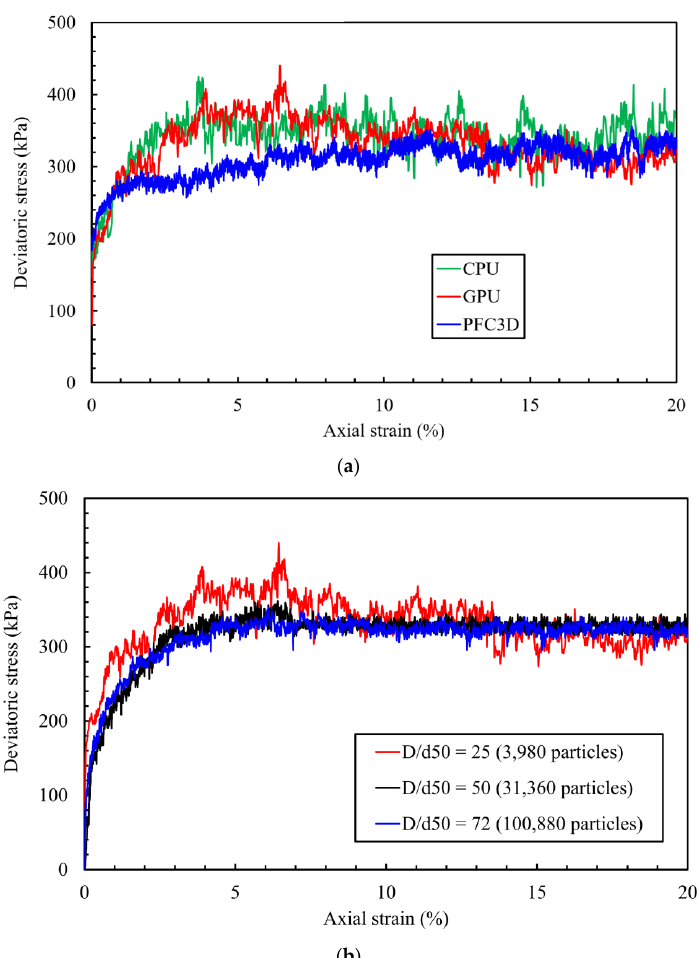
Figure 5. Deviator stress changes versus axial strain during triaxial tests with confining stress of 300 kPa. ( a ) with different tools ( b ) influence of model size. Table 2. Speedups of GPU parallel calculations for the procedures in triaxial test cases.